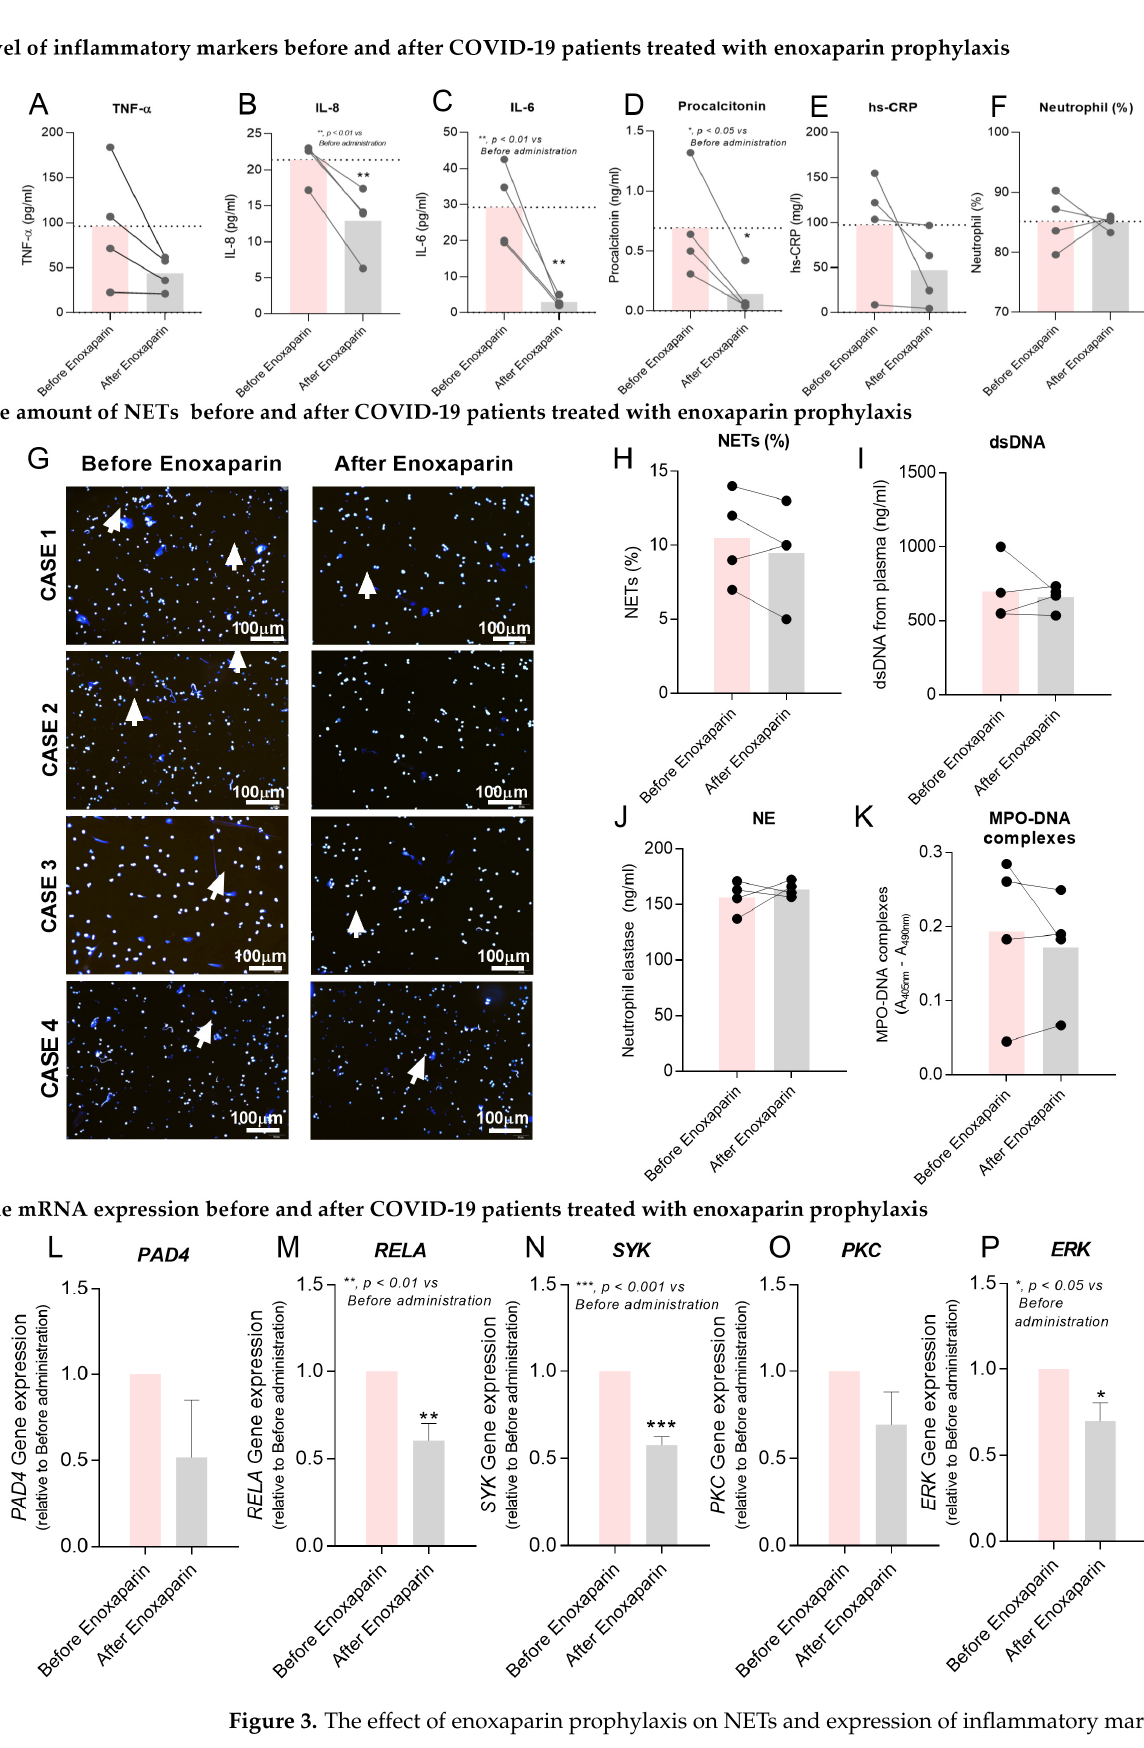
Figure 3. The effect of enoxaparin prophylaxis on NETs and expression of inflammatory markers